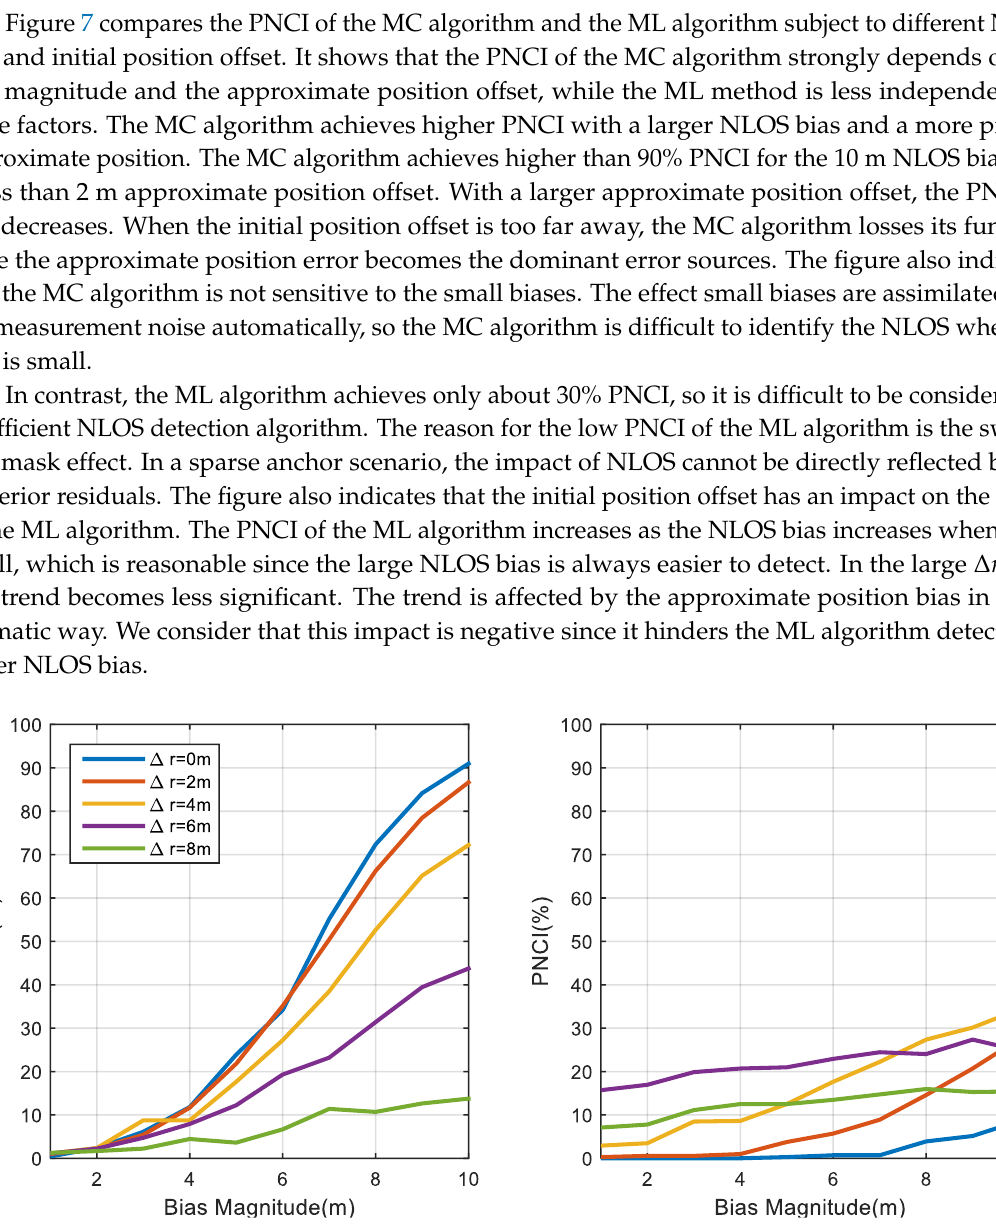
Figure 7. Compare of PNCI with different NLOS bias and initial coordinates for the MC algorithm ( Left ) and the ML method ( Right ( Left ) and the ML method ( Right ).